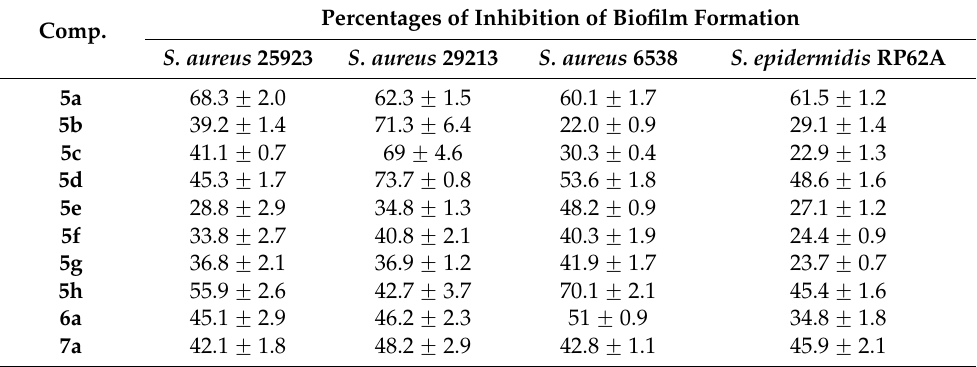
Table 2. Inhibition of biofilm formation of compounds 5a – h , 6a and 7a at 100 µ M concentration.